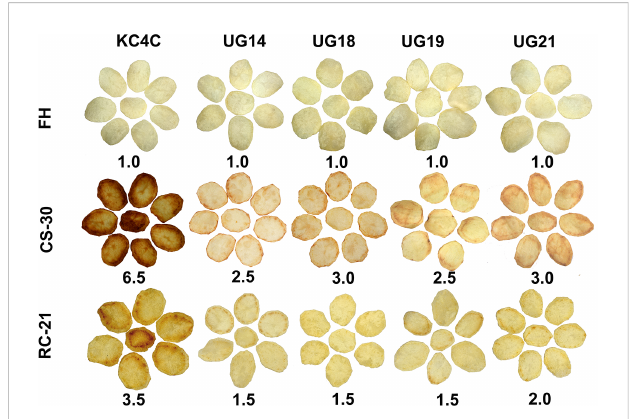
FIGURE 3 Cold chipping performance of the four best performing UGPase RNAi potato transgenic lines of KC4 at fresh harvest (FH), after 30 days of cold storage (CS) and after 21 days of room temperature reconditioning (RC) of the cold stored tubers. The number below chips of each line indicates chip colour